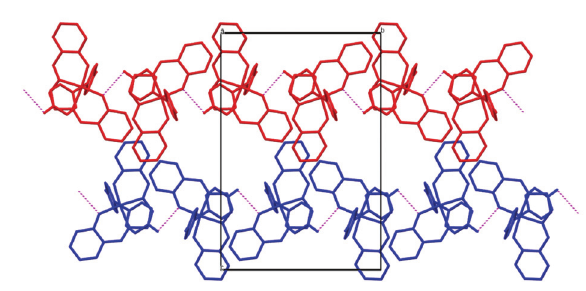
Figure 6. A packing diagram of compound 2 viewed along a axis. Note the formation of channels which are filled by disordered PF anions.